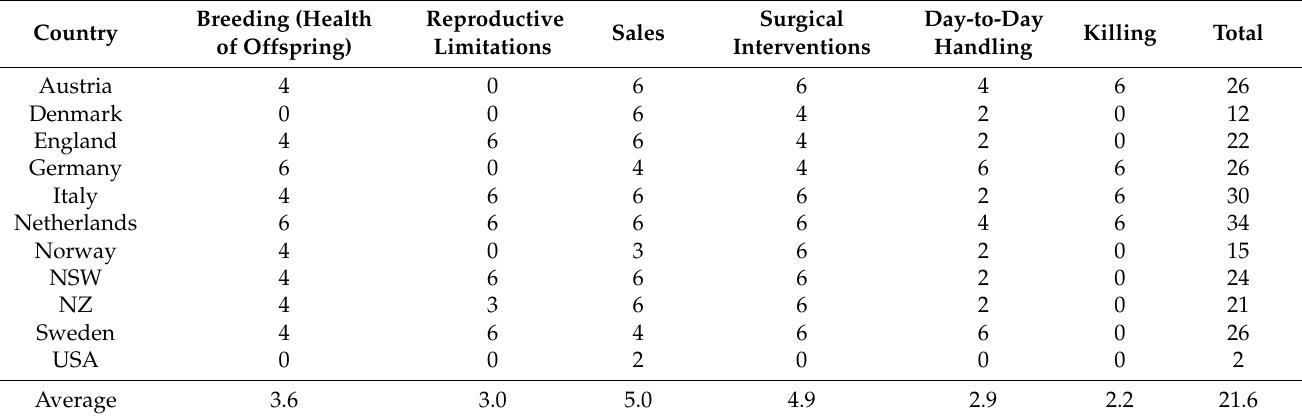
Table 1. Degrees of regulation in a range of welfare categories for companion dogs. Note that the numbers indicating degrees of regulation are not intended to capture the welfare benefit to the